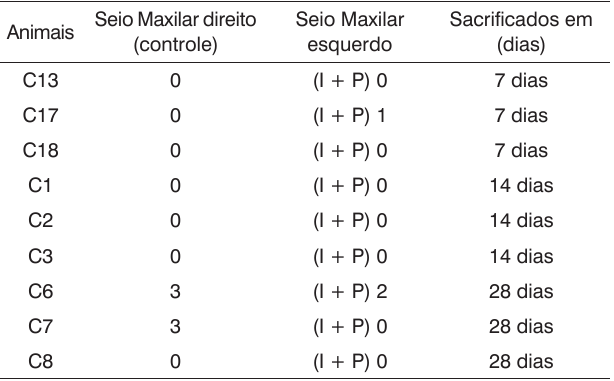
Figura 5. A: Mucosa de seio maxilar esquerdo de um animal (coelho 1) sem processo inflamatório e sem sinais de toxicidade (Coloração HE, aumento10X). B: Mucosa de seio maxilar esquerdo de um animal (coelho 5) mostrando processo inflamatório moderado (Coloração HE, aumento10X). Tabela 1. Avaliação histológica da inflamação presente na mucosa dos animais do Grupo 1.